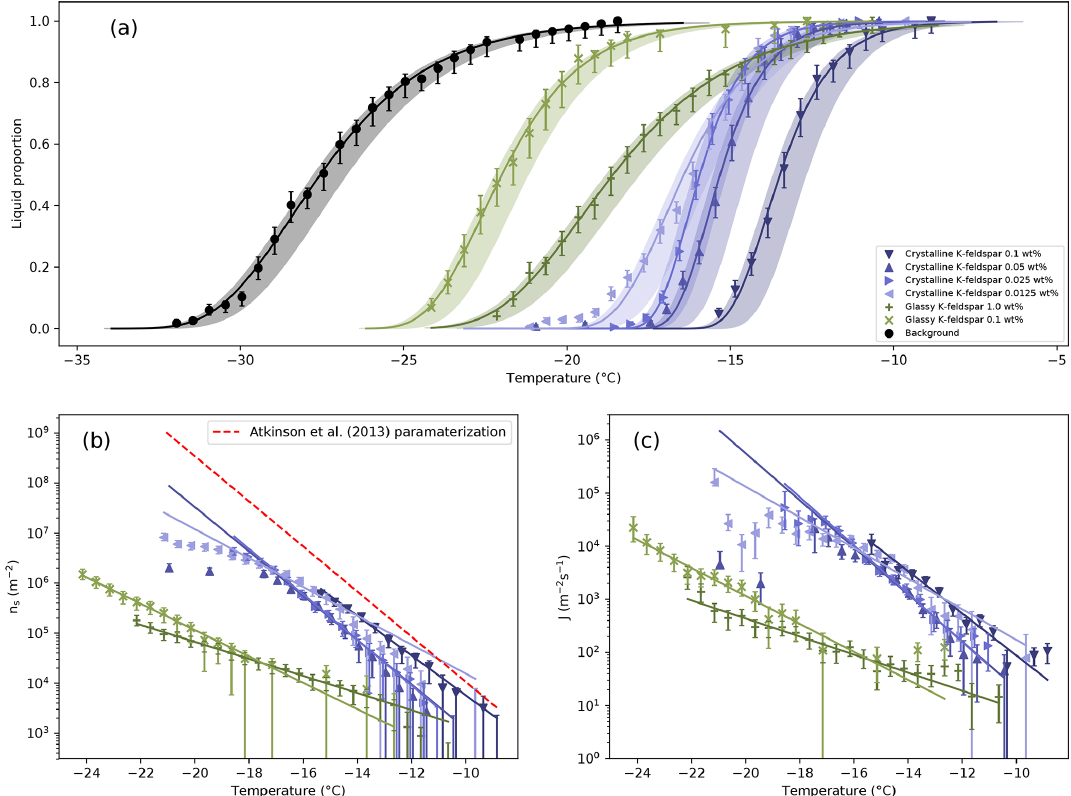
Figure 5. (a) Liquid proportion curves for 1µL droplets of water containing different fractions of glassy and crystalline K-feldspar. The background freezing rate of the instrument is also shown. Temperature errors are shown by the shading. Details on the lines of best fit can be found in the Supplement. (b) Ice nucleation active site density, normalized by the surface area present in each droplet. The red dashed line is the parameterization from Atkinson et al. (2013), which is partly based on microlitre-sized droplets with similar concentrations to those used here. (c) Freezing rates normalized by the surface area present in each